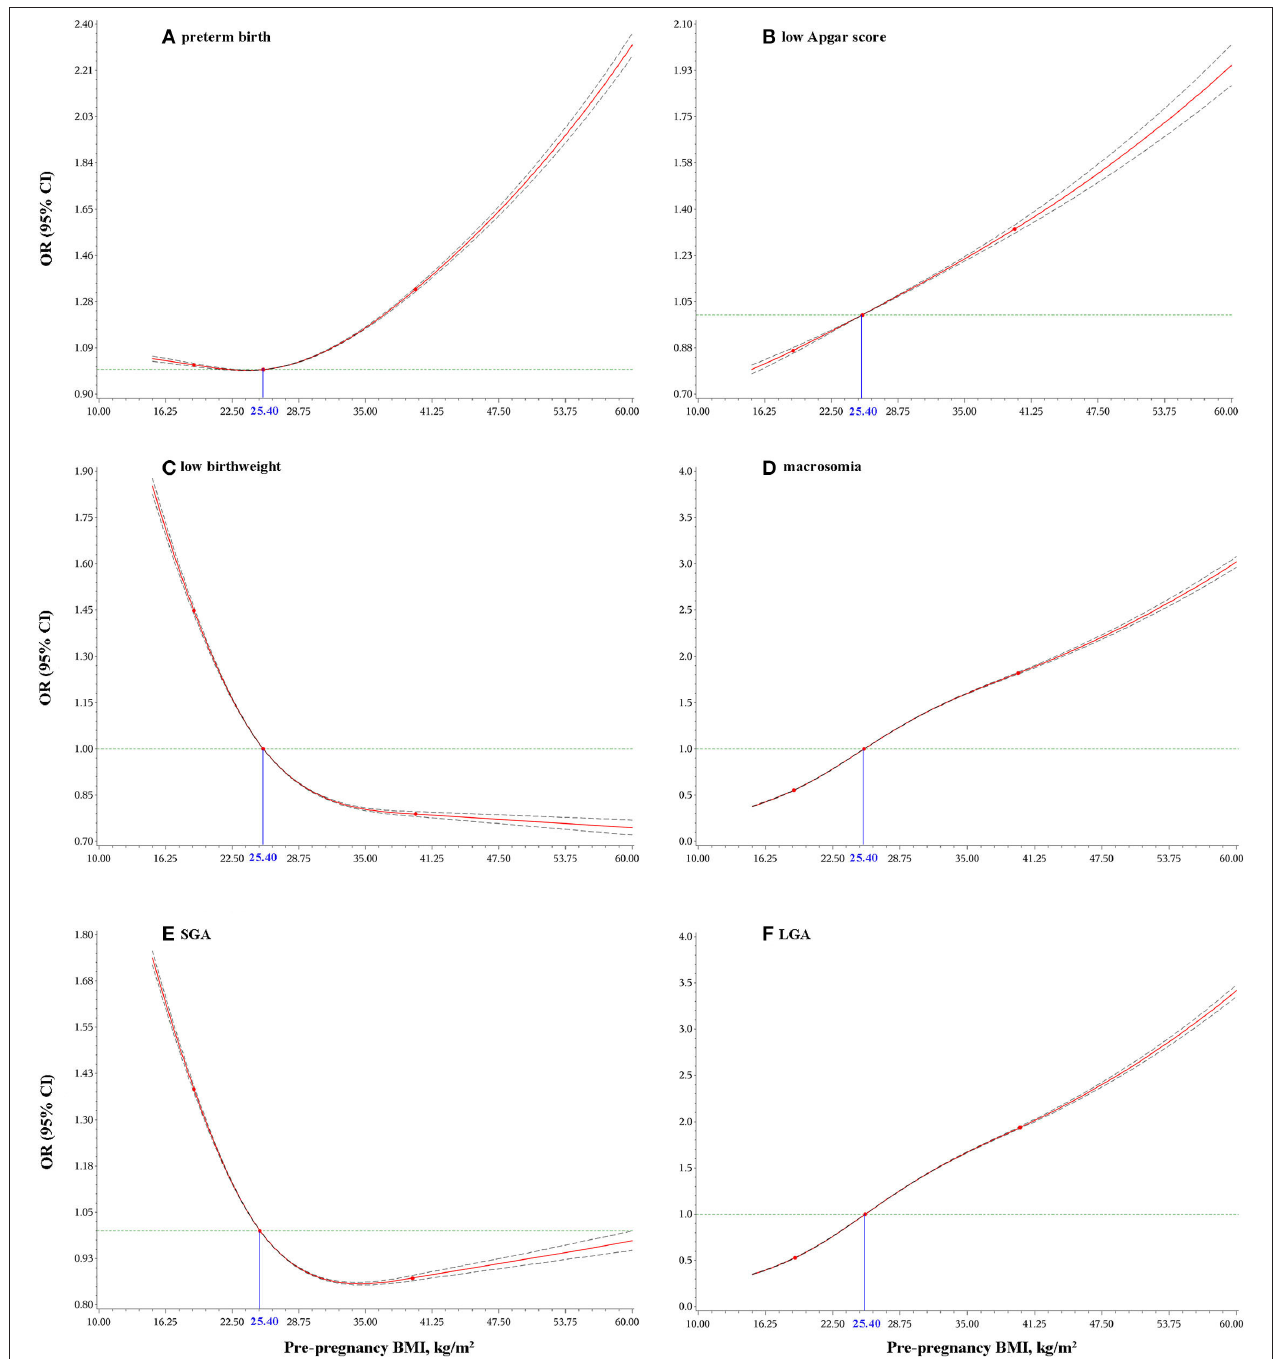
FIGURE 2 | Dose-response relationship of maternal pre-pregnancy BMI with: preterm birth (A) ; low Apgar score (B) ; low birthweight (C) ; macrosomia (D) ; small for gestational age (SGA) (E) ; and large for gestational age (LGA) (F) . Odds ratios (ORs) and 95% confidence intervals (CIs) were calculated after adjusting for maternal age at delivery, race/ethnicity, education levels, marital status, smoking status during pregnancy, live-birth order, infant sex, gestational age (for low birthweight, macrosomia, or low Apgar score only), and total number of prenatal care visits.